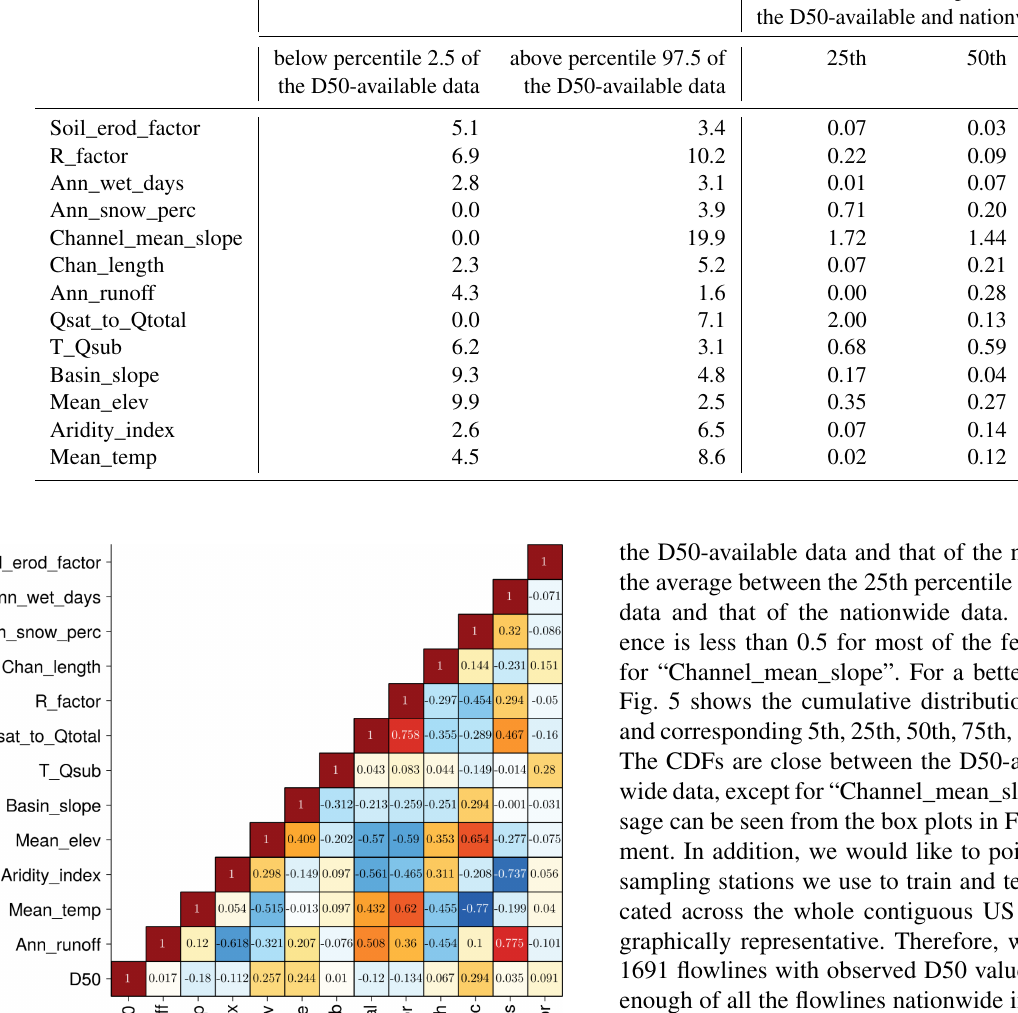
Table 2. Comparison of the ranges and percentiles of 13 input features between the D50-available and nationwide datasets. Attributes Percent of nationwide data that is Relative difference in percentiles between the D50-available and nationwide data below percentile 2.5 of above percentile 97.5 of 25th 75th the D50-available data